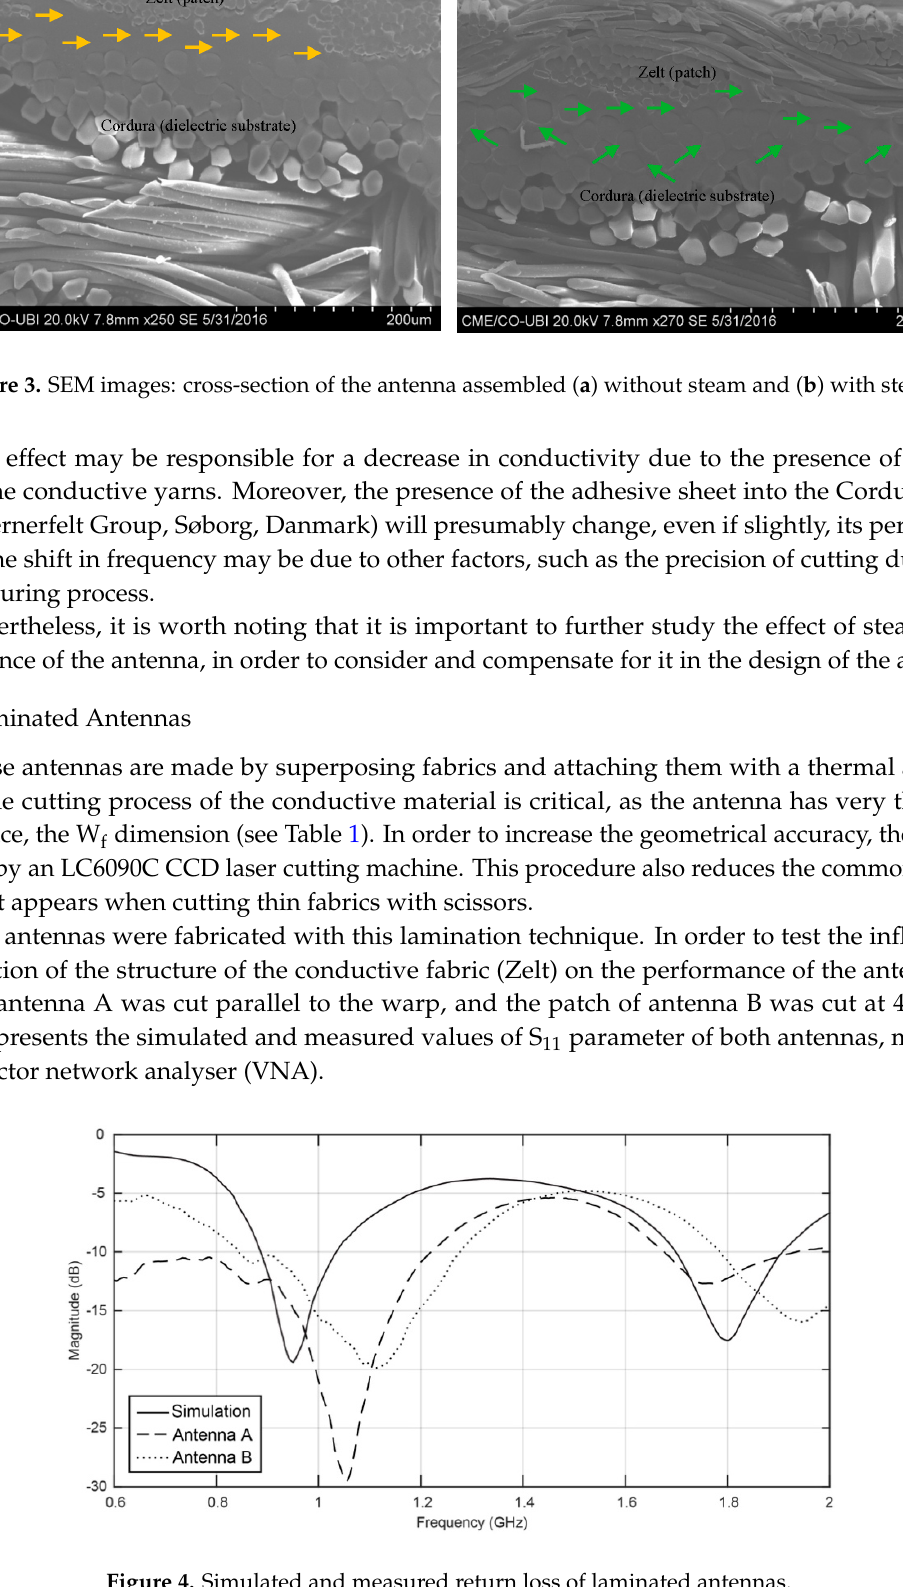
Figure 4. Simulated and measured return loss of laminated antennas.